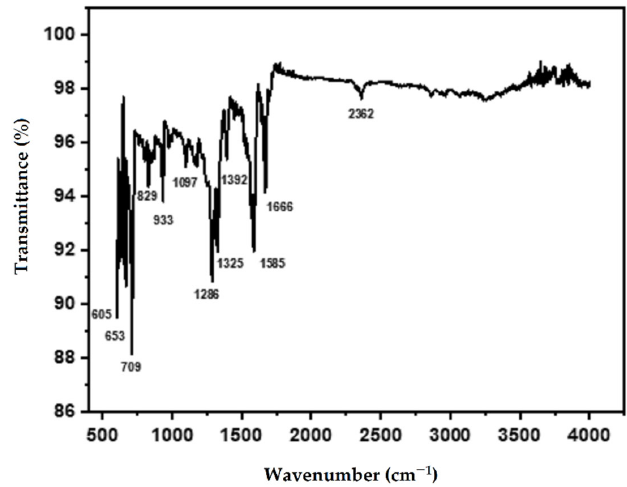
Figure 4. UV–vis absorption spectrum of PAD.